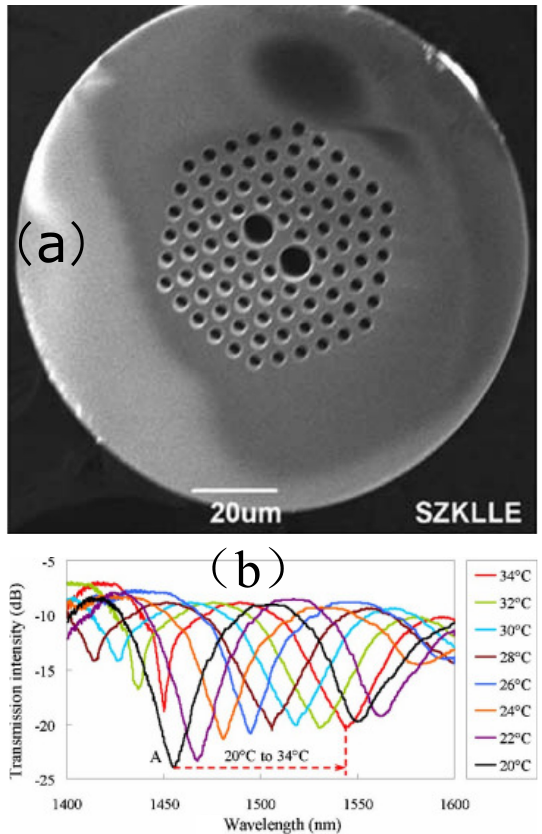
Figure 9. ( a ) SEM of the used photonic crystal fiber; ( b ) transmission spectra of the alcoholfilled HiBi- PCF FLM ( a ) when the temperature increases from 20 °C to 34 °C [48]. Reprinted with permission from Ref. [48]. Copyright 2011 The Optical